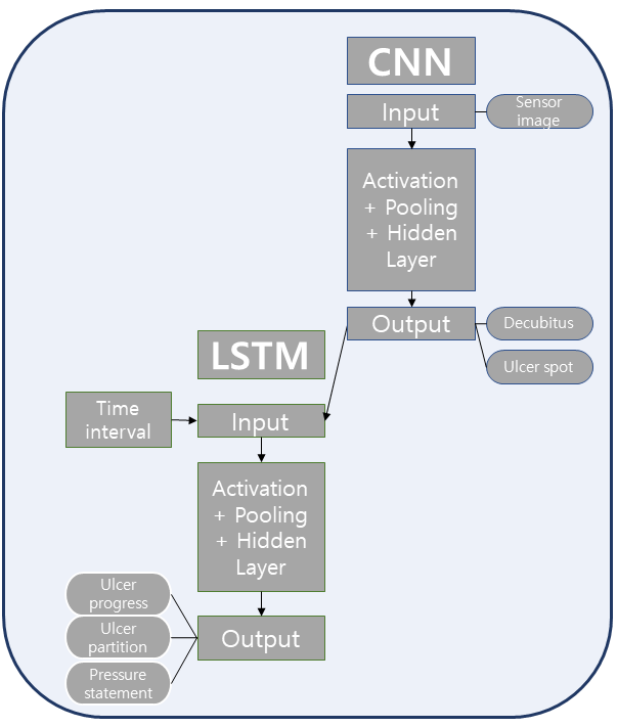
Figure 3. Schematic diagram of the ConvLSTM architecture used within the FICL model. This includes the multi-input data, which is separately fed into the CNN and the LSTM.